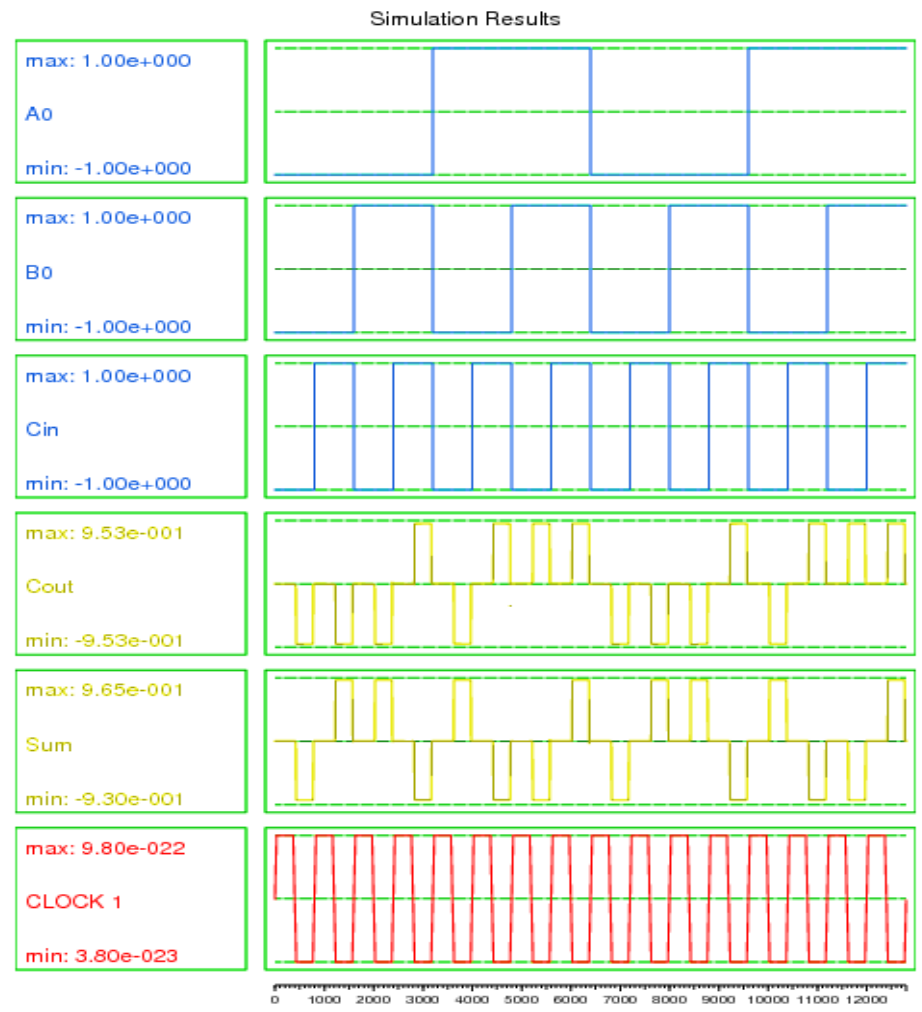
Figure 5. The QCA layout with ( a , b ) FA circuits.